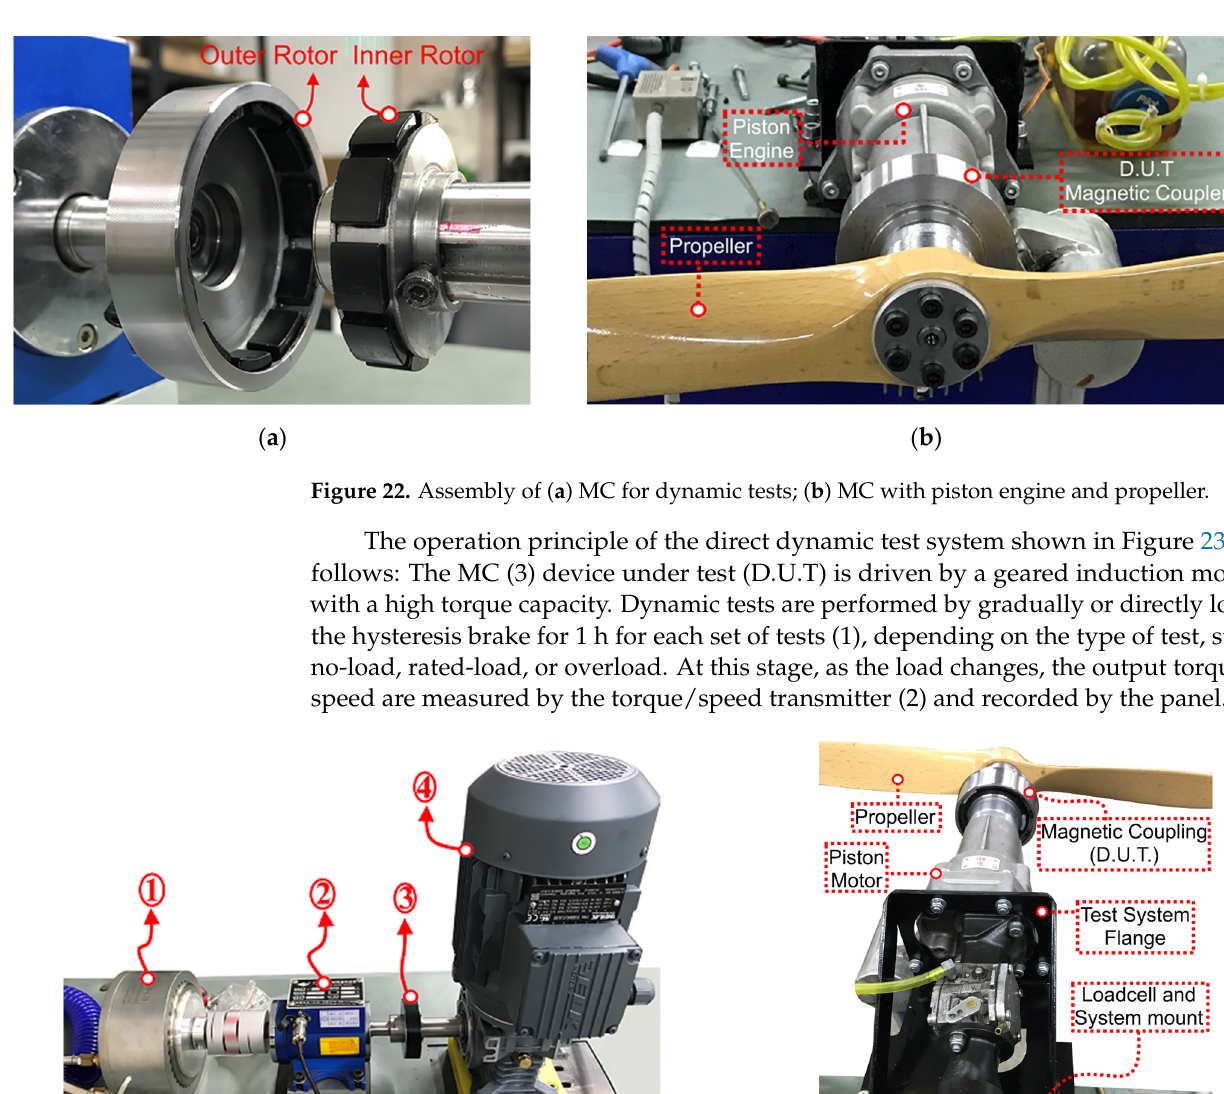
( e ) Figure 21. Various MC productions of: ( a ) 8-pole/0.8-embrace/3 mm-PM thickness/10 mm length; ( b ) 8-pole/0.98-embrace/4 mm-PM thickness/10 mm length; ( c ) 10-pole/0.8-embrace/4 mm-PM thick- ness/10 mm length; ( d ) 10-pole/0.98-embrace/4 mm-PM thickness/10 mm length; ( e ) 10-pole/0.98- embrace/4 mm-PM thickness/20 mm length. Due to the MCs being included in the group of noncontact electrical machines [57], their performance examinations are carried out in a similar way to special rotating ma- chines, using direct or indirect test methods [58]. On the other hand, the propulsion plat-